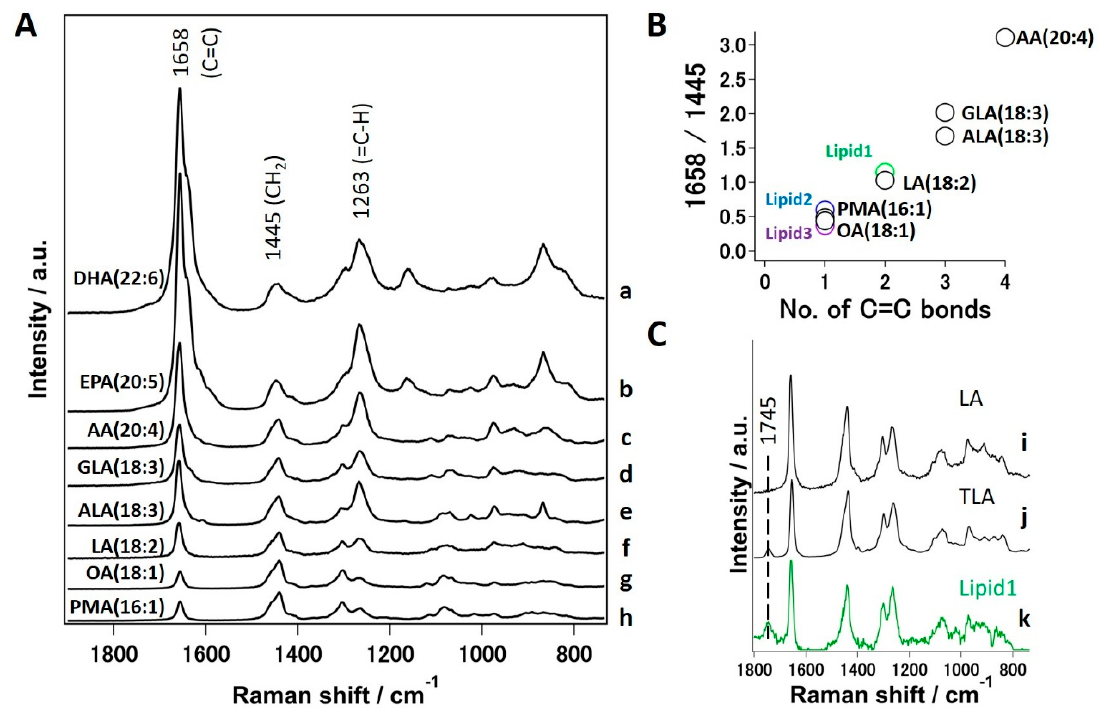
Figure 6. Molecular level assignment of Raman spectral marker. ( A ) Standard Raman spectra of various unsaturated fatty acids normalized using 1445 cm − 1 band; ( a ) docosahexaenoic acid(DHA), ( b ) eicosapentaenoic acid (EPA), ( c ) arachidonic acid (AA), ( d ) γ -linolenic acid (GLA), ( e ) α -linolenic acid (ALA) ( f ) linoleic acid (LA), ( g ) oleic acid (OA) and ( h ) palmitoleic acid (PMA). ( B ) Unsaturation index plot. Relative intensity ratio of C=C/CH2 vs. number of C=C bonds in standard unsaturated fatty acids. Relative intensities obtained from three lipids on MCR-ALS components are also plotted and denoted in color. ( C ) Comparison of standard ( i ) LA, ( j ) Trilinolein (TLA) and ( k ) Lipid 1 extracted by MCR-ALS.